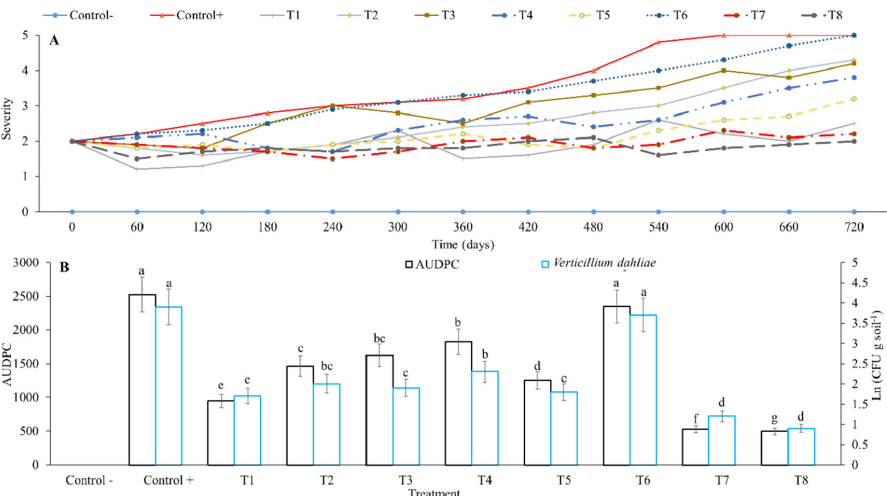
Figure 4. Area under disease progress curve (AUDPC), and inoculum of Verticillium dahliae under management practices of disease on field conditions. ( A ): Dynamics of the severity of V . dahliae under different treatments. ( B ): AUDPC of V . dahliae under different treatments. Error bars represent the confidence interval of the mean, validated by Tukey mean separation test. Equal letters indicate that there are no significant differences ( p > 0.05). The following treatments were evaluated under field conditions (where “fi” stands for field conditions): fi—healthy control: non-inoculated control of healthy plants; fi-diseased control: plants infected with V . dahliae ; T1fi (fungicide): Verticillium -infected plants + application